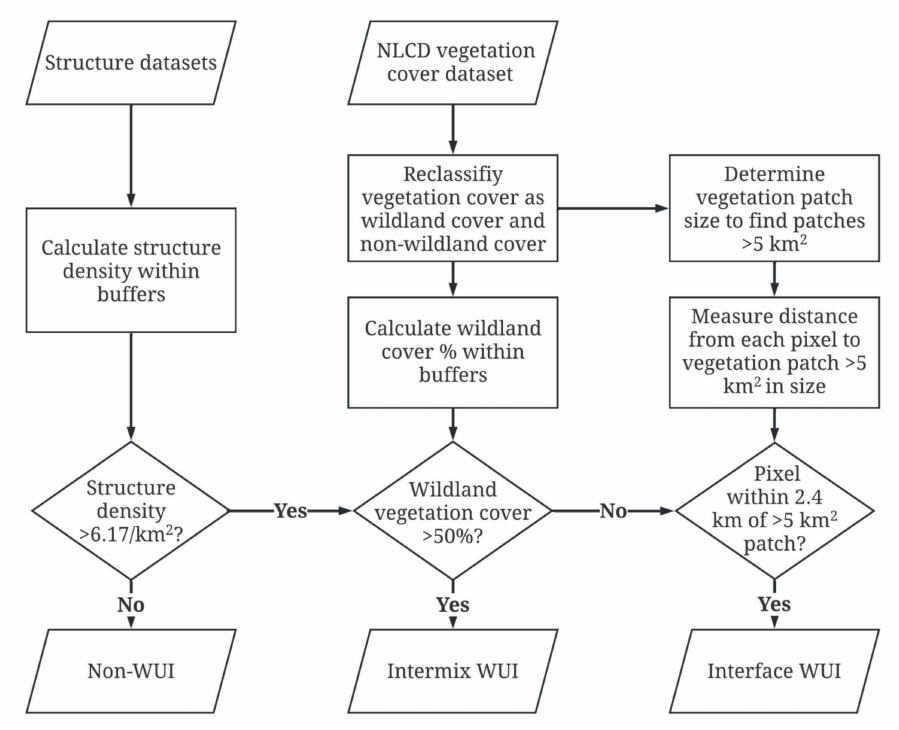
Figure 2. The flowchart of the WUI mapping